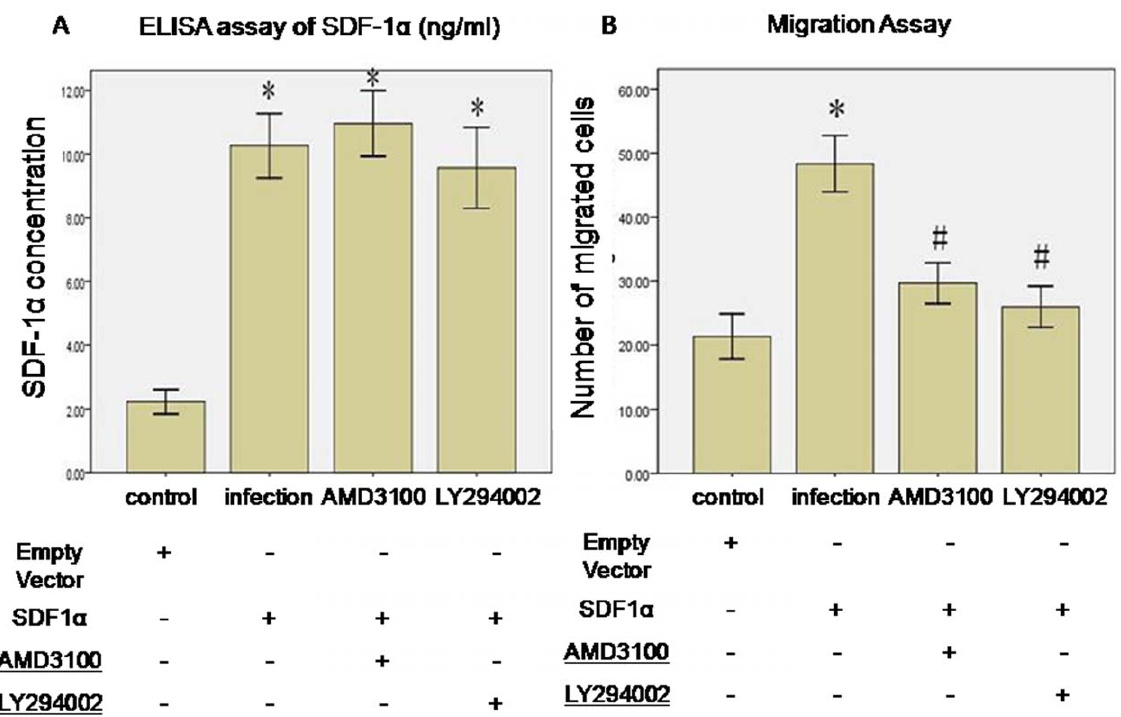
Figure 2. SDF-1 a /CXCR4 induced CSCs migration via PI3K pathway. A . rAAV1-SDF-1 a -eGFP infection increased SDF-1 a concentration in supernatant. *p , 0.01 vs. control. n=3. B . SDF-1 a -induced CSCs migration was inhibited by AMD3100 and LY294002. *p , 0.01 vs. control. # p , 0.05 vs. infection group. Data were shown as mean 6 SD. n=3. SDF-1 a /CXCR4 reduced MI size via PI3K pathway